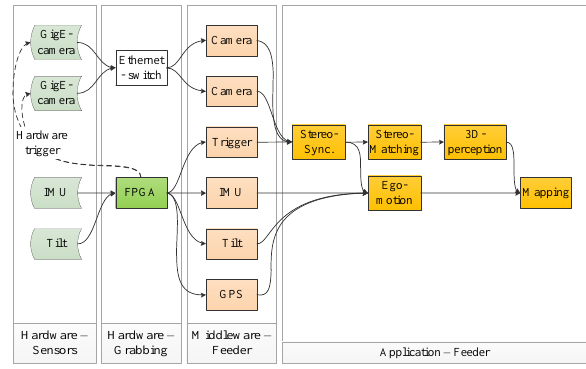
Figure 5: Example for sensor data processing